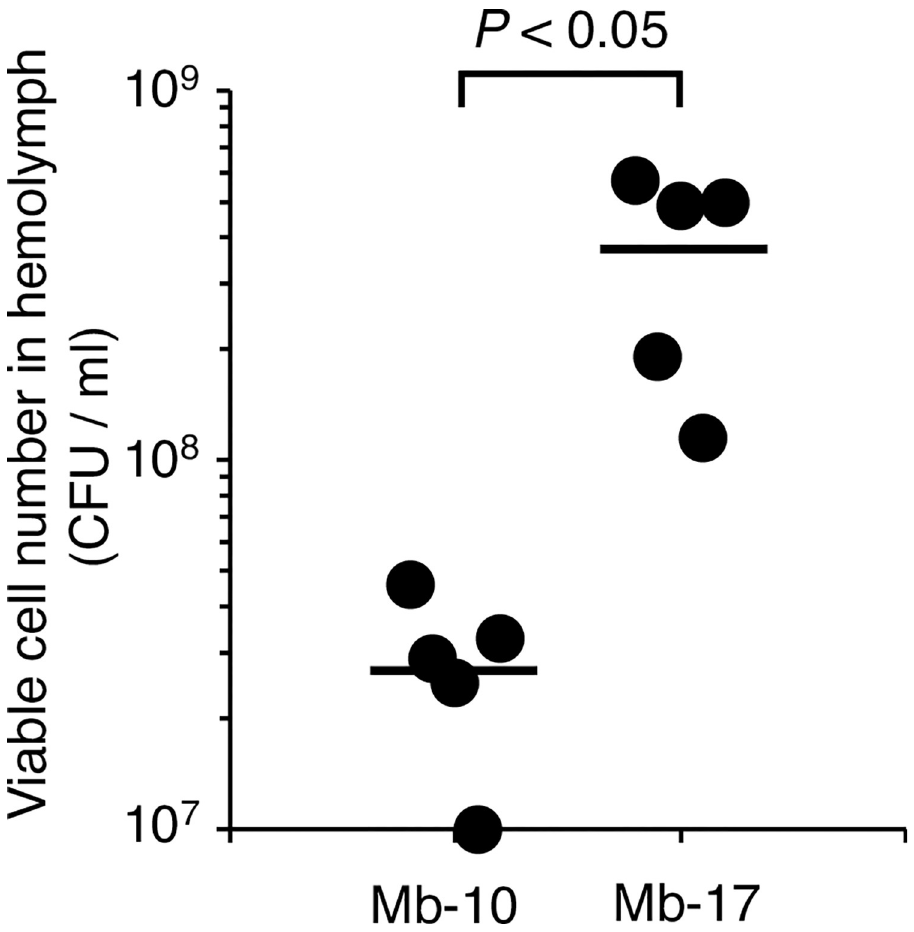
Fig 6. Viable cell counts of M . abscessus subsp. abscessus Mb-10 and Mb-17 isolates in silkworms. Silkworms were injected with saline (50 μ l) or M . abscessus subsp. abscessus Mb-10 cell suspension (3.6 x 10 8 cells per 50 μ l) or Mb-17 cell suspension (3.8 x 10 8 cells per 50 μ l) and incubated at 37˚C. Silkworm hemolymph was harvested at 18 h post- infection. Five silkworms were used per group. Statistically significant differences between groups were evaluated using the Student t